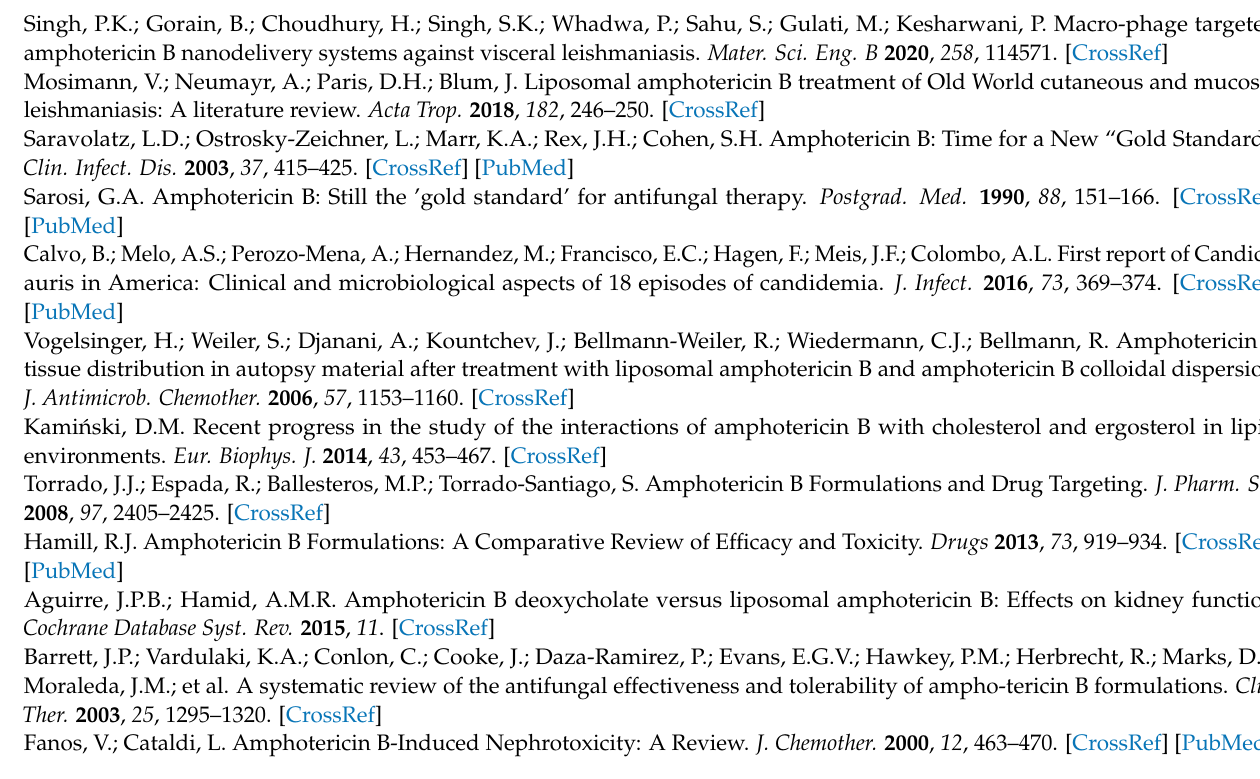
analysis. Figure S1: 1 H-NMR spectra of (a) PP3 and (b) PP3-succinic acid copolymers. Figure S2. solubility profiles of AmB in the presence of copolymers. Figure S3. AFM images of representative samples AmB/PP3 (a) and AmB/PP3-DSPE